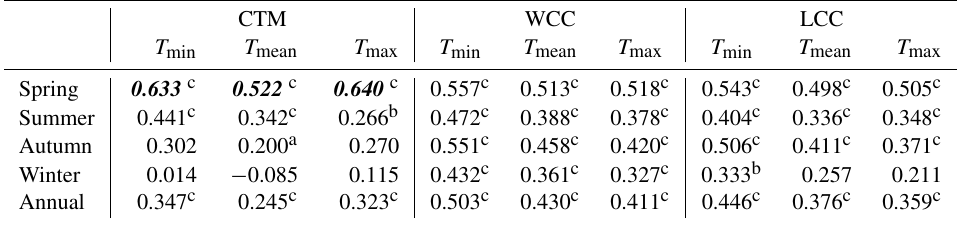
Table 3. Annual and seasonal temperature trends ( ◦ C10a − 1 ) in the CTM (based on the CTMD) and all of continental China (WCC) and low-altitude areas (LCC) (both based on the CMA05) from 1979 to 2016. CTM WCC